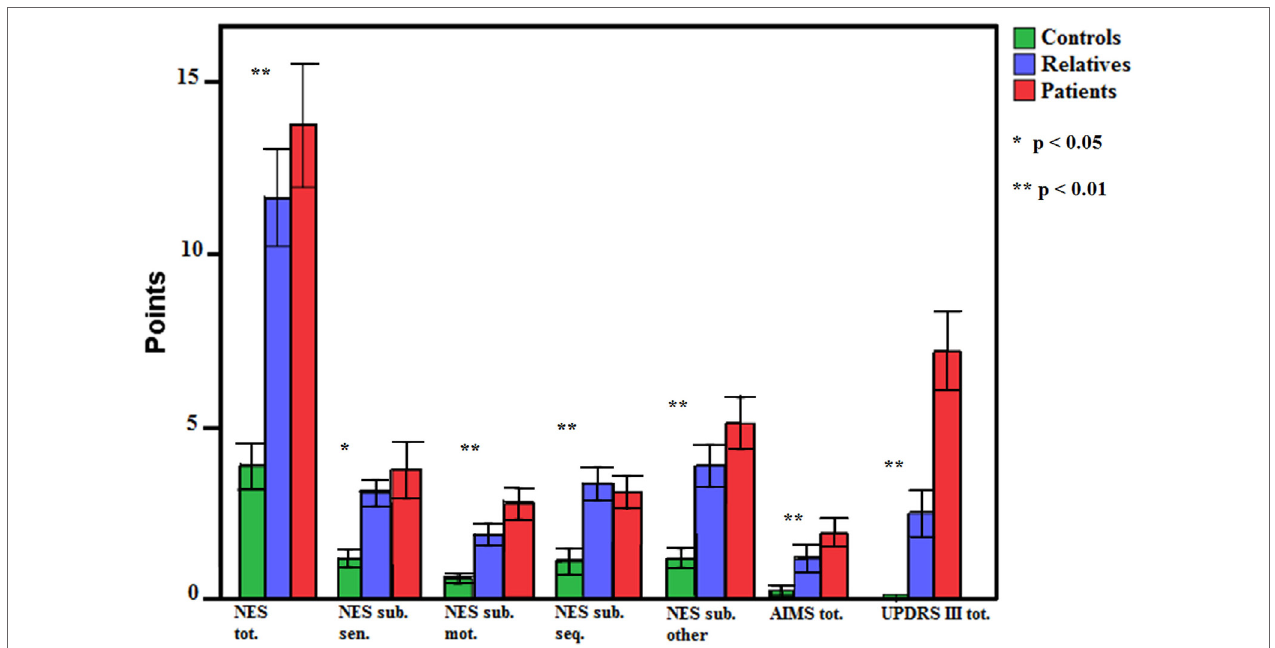
FigUre 1 | Group differences of neurological soft sign, dyskinesia, and Parkinsonism in patients, relatives, and controls. Error bars indicate SE. NES, Neurological Evaluation Scale; sub., subscale; sen., sensory motor function; mot., motor coordination; seq., motor sequencing; AIMS, Abnormal Involuntary Movement Scale; UPDRS III, Unified Parkinson’s Disease Rating Sale motor part III.